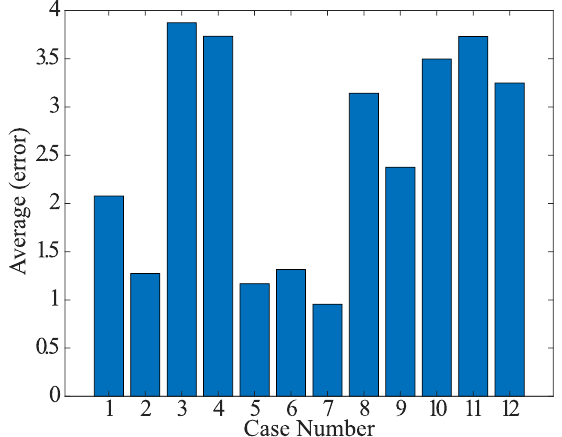
Figure 24. Comparison of each data in Table 1 (average).